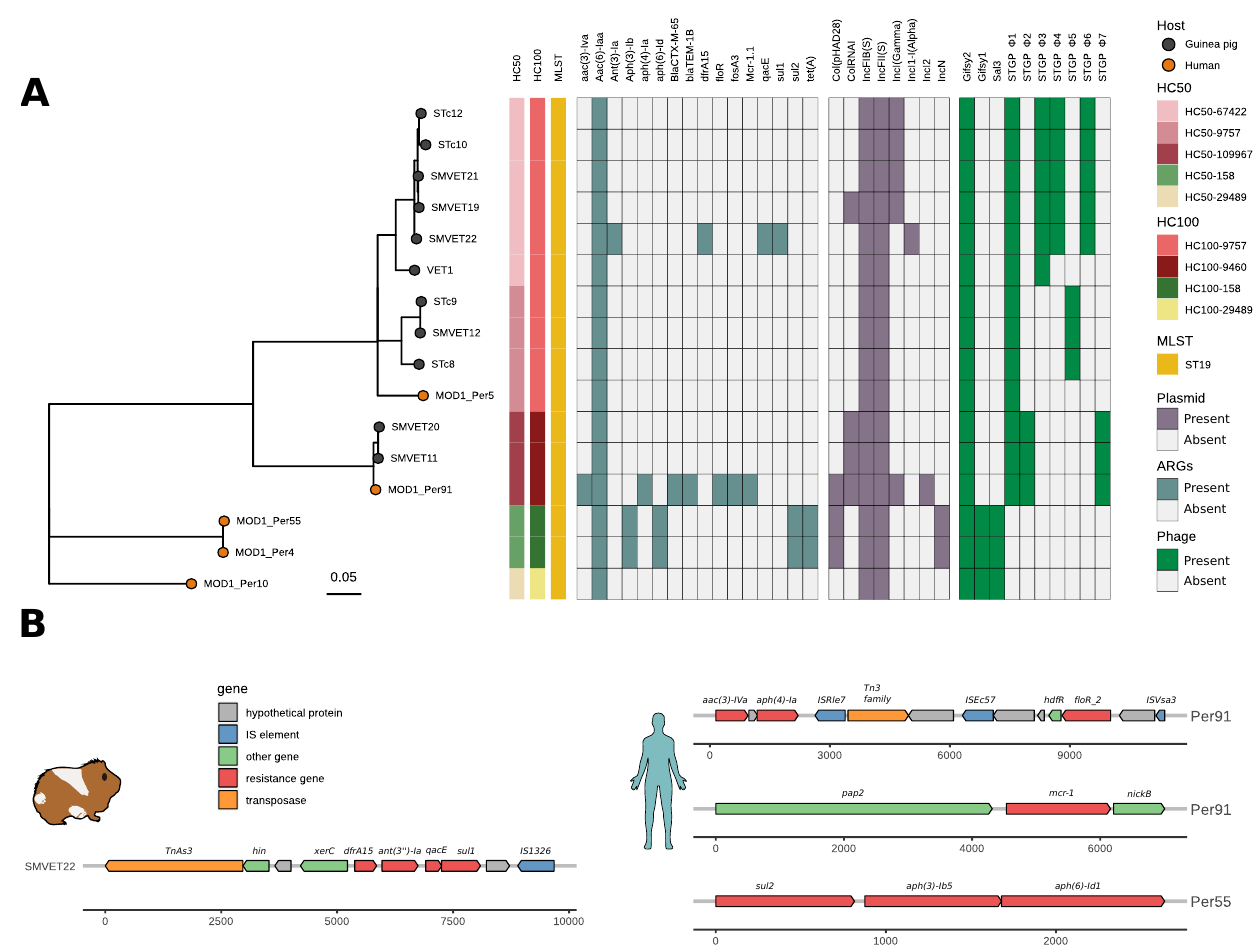
Figure 2. ARGs, plasmid, and phage profile in Peruvian S. Typhimurium isolates. ( A ) Phylogenomic tree based on SNP alignment of S. Typhimurium isolates including 11 from guinea pigs and 5 from human origin. Heatmap showing presence/absence of ARGs (blue), plasmid replicon (purple), and prophages (green). ( B ) Genetic context of ARGs detected in guinea pig and human isolates; the annotation of each gene in different colors is shown as per the